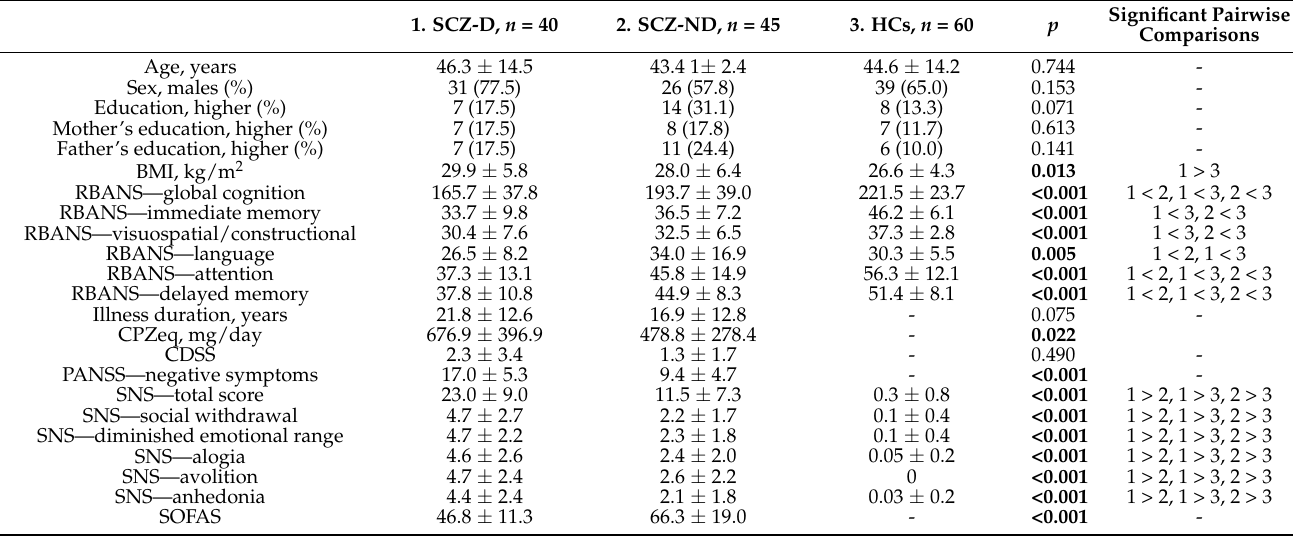
Table 1. General characteristics of the